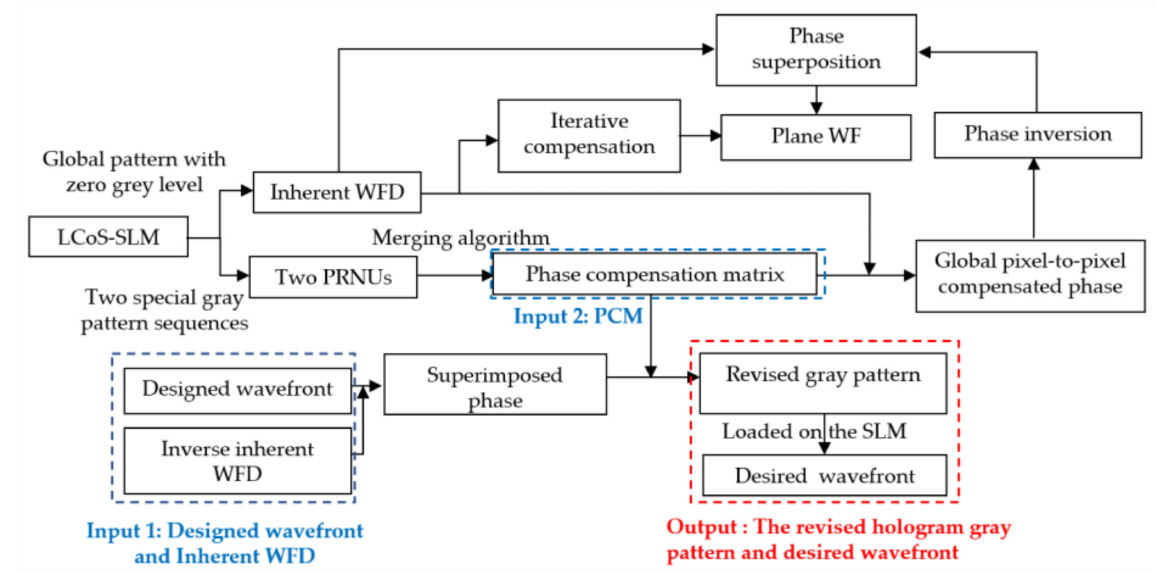
Figure 2. Strategy of phase compensation for LcoS-SLM.